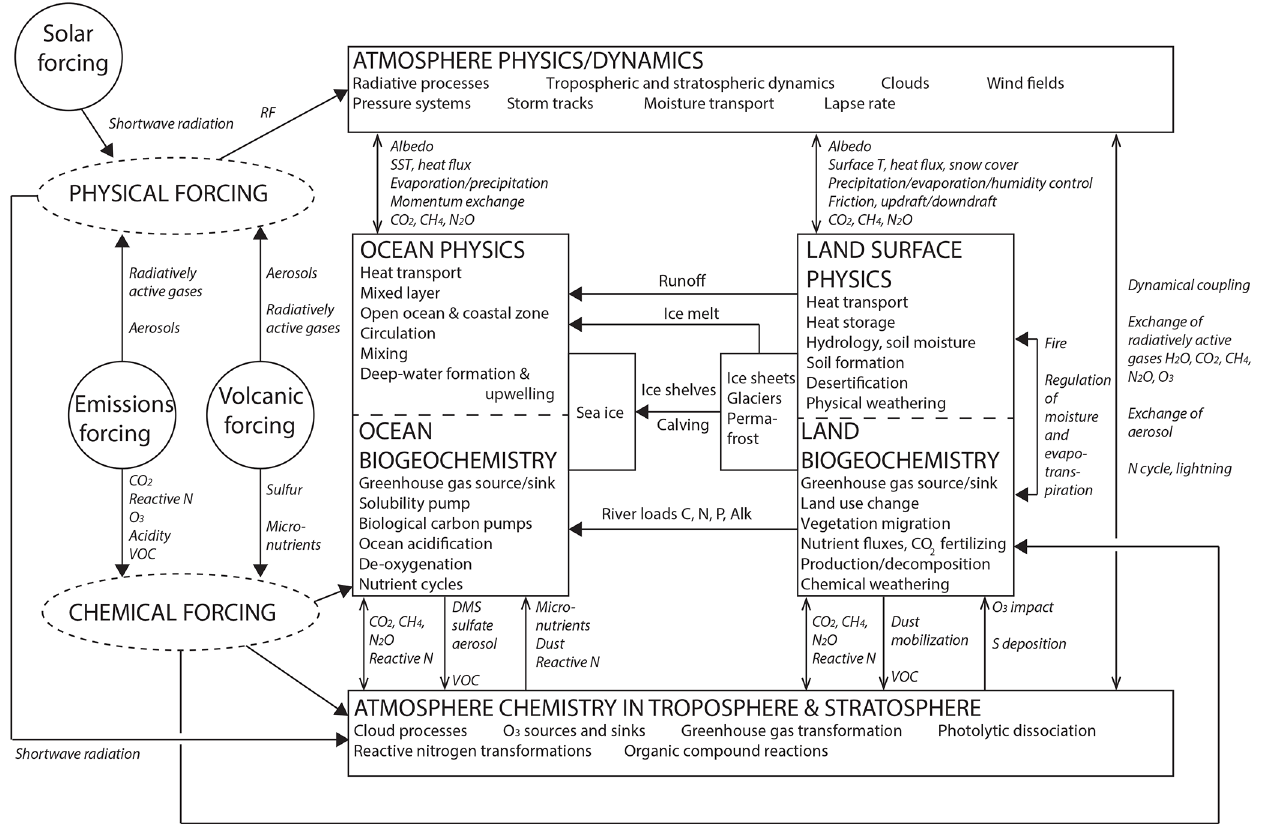
Figure 1. The Earth system as an extension of the physical climate system (“Bretherton diagram” drawn anew with modifications, extensions, and simplifications, following the idea of Bretherton (1985). The original “Bretherton diagram” is given in the